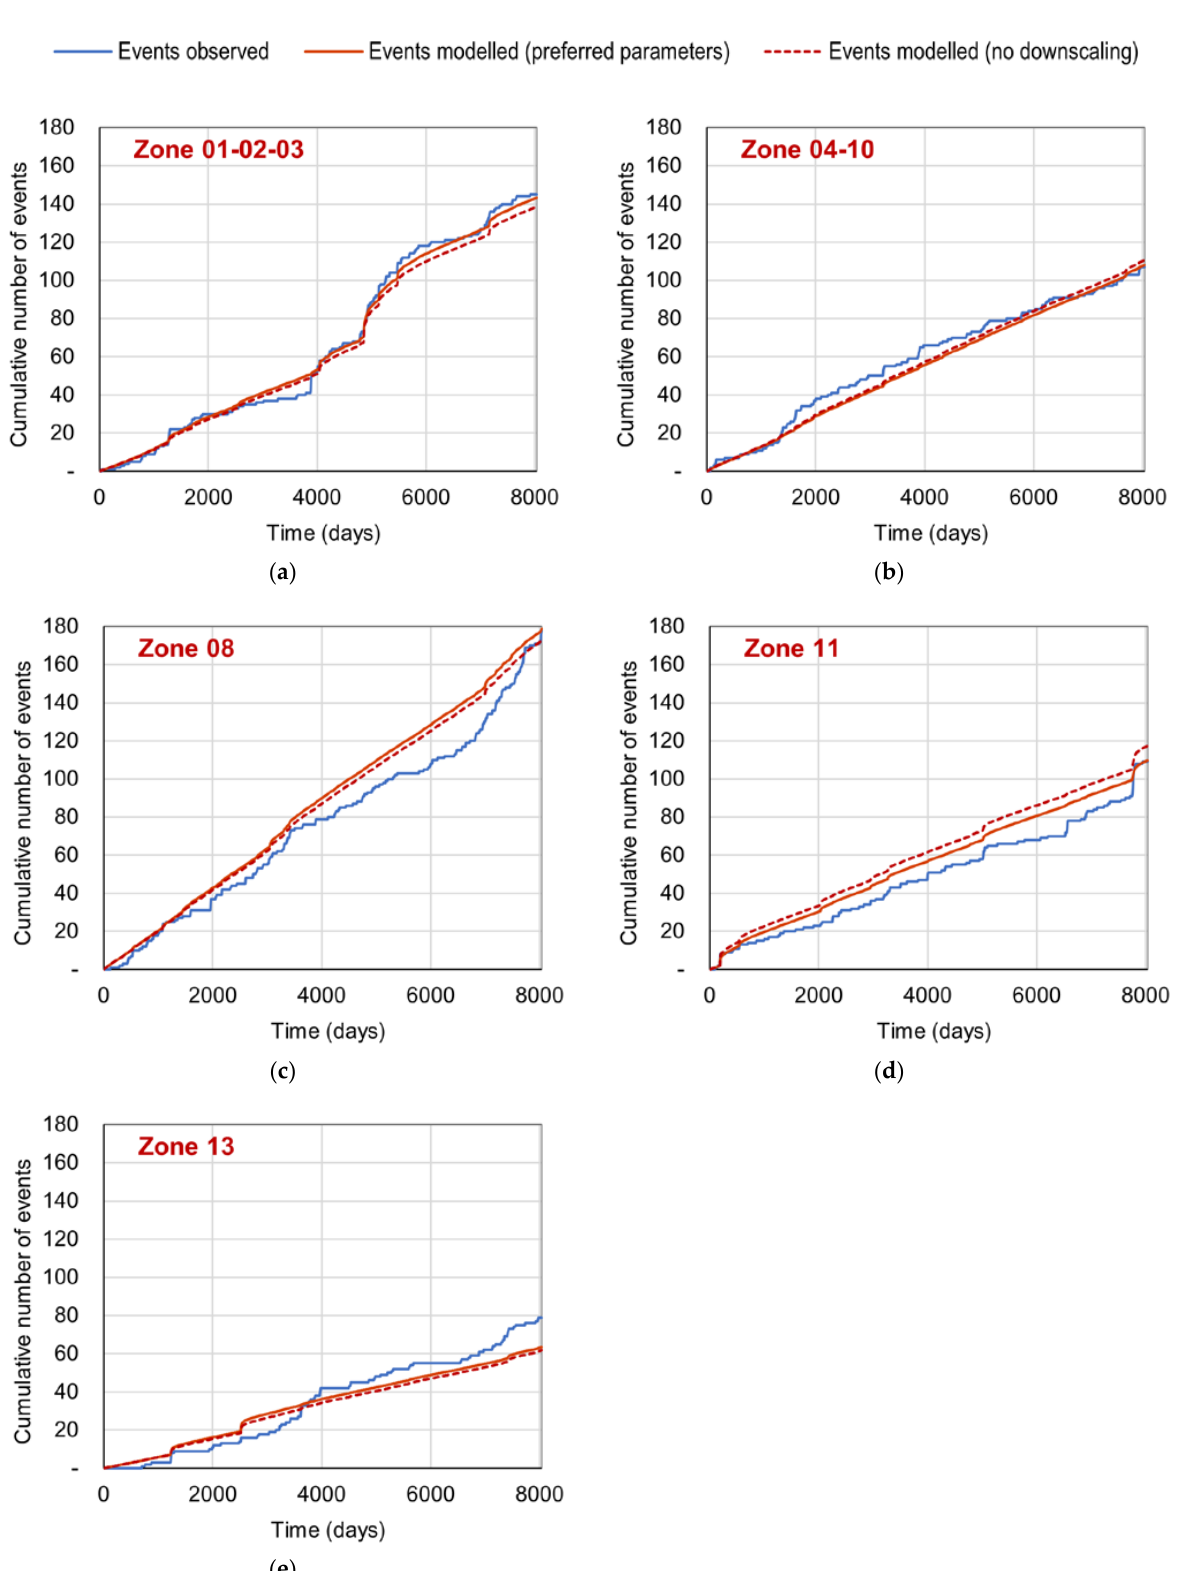
Figure 13. Modelled versus observed event accumulation by zone in the study period 2000–2021 for M ≥ 2.5. ( a – e ) Results of the test shown for each zone. Zones 05–06 and 99 with no downscaling are